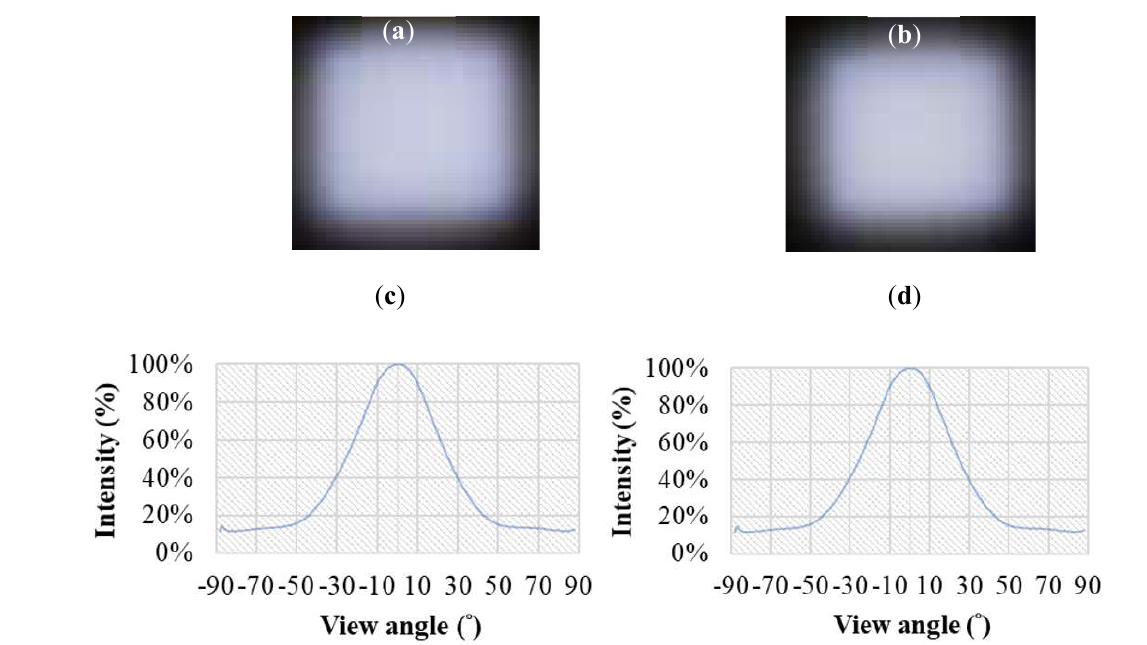
Figure 17. Lit-up sample of extra-thin, large-area, high-luminance surface light source BLU module: ( a ) without concave PSMLAs; ( b ) with concave PSMLAs; ( c ) light distribution curve without concave PSMLAs; ( d ) light distribution curve with concave PSMLAs.